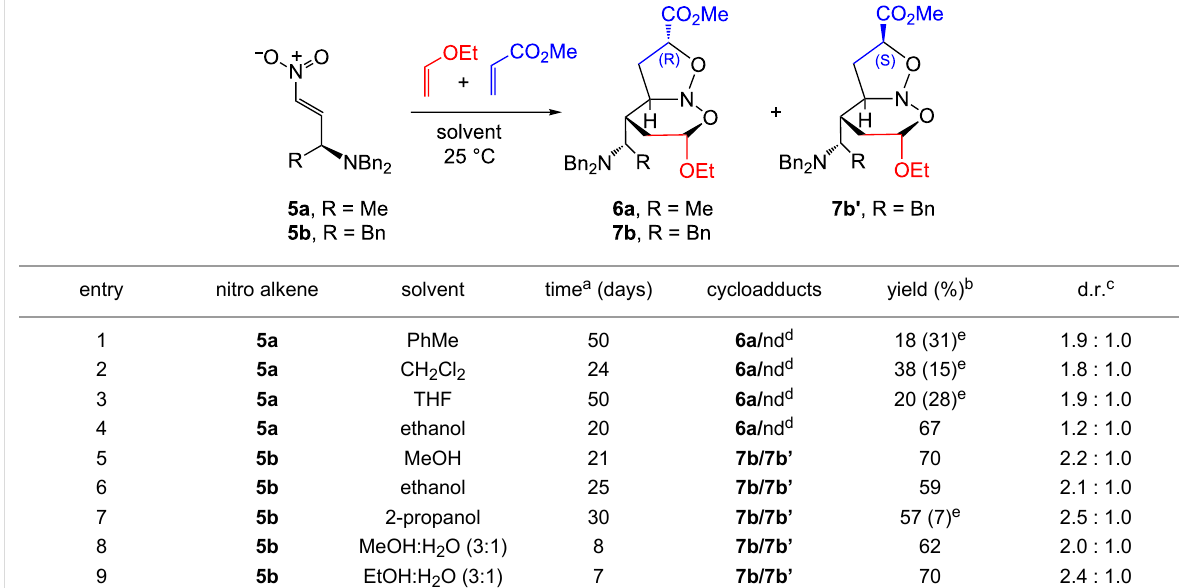
Table 1: Nitroso acetal synthesis via multicomponent [4 + 2]/[3 + 2] cycloadditions of 5a , b with EVE and methyl acrylate in several